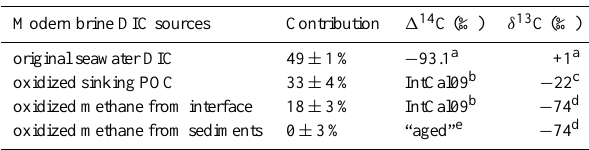
Table 3. Modeled apportionment of DIC sources in Orca Basin